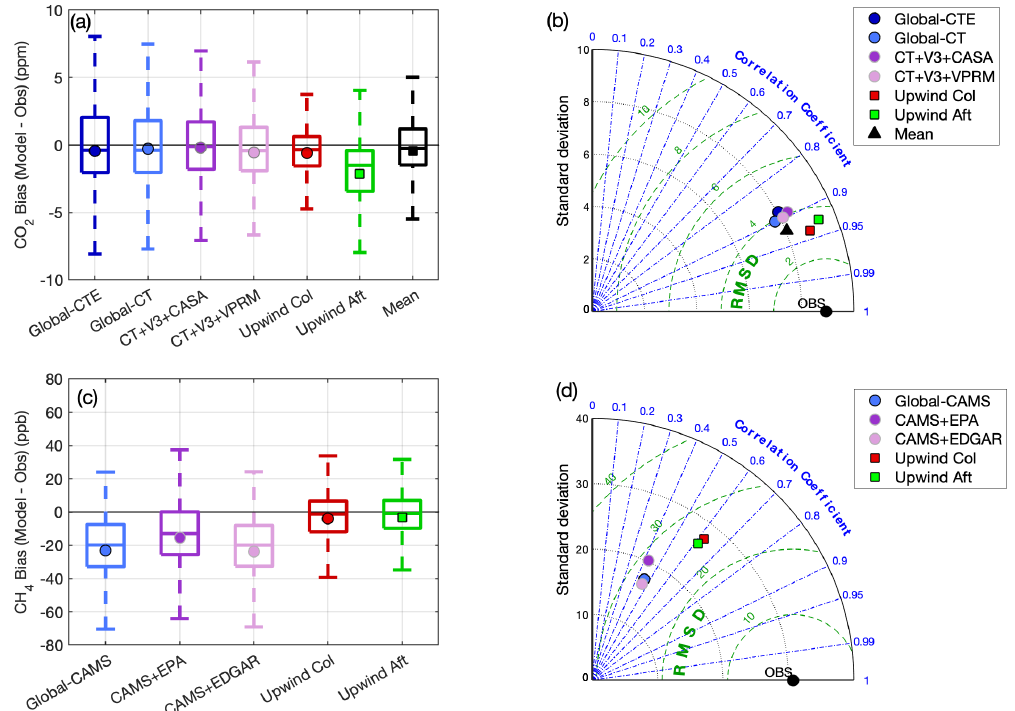
Figure 7. Annual statistics for modeled vs. observed mole fractions over all six urban sites for CO 2 (a, b) and CH 4 (c, d) using identical fluxes in the inner domain with the different backgrounds from Table 1. For CO 2 , we also include the mean of the first five (excluding upwind aft). (a, c) Bias (model–observations, afternoon hours); center line is the median value of the bias over all low-footprint hours of the year; symbol is the mean; box edges indicate 25th and 75th percentiles (inter-quartile range); whiskers show range excluding outliers; outliers not shown. (b, d) Taylor diagram (Taylor, 2001) illustrating performance replicating the standard deviation of the afternoon observations (black axes at constant radius), correlation (blue angular axes), and root-mean-square deviation (RMSD, green arcs).